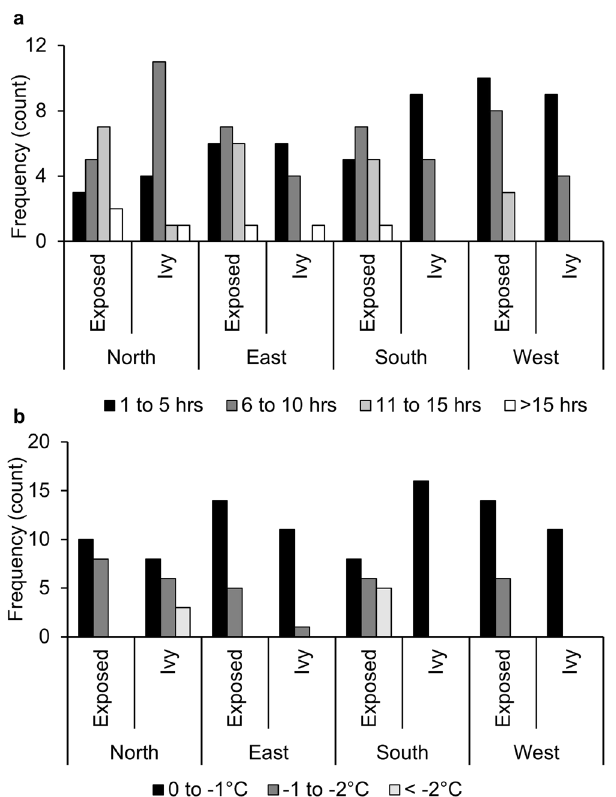
Figure 2. Number of frost events of differing ( a ) duration, hours, and ( b ) severity, °C, recorded on test walls with and without a cover of ivy (winter 2012/13 and 2013/14), Wytham Woods,